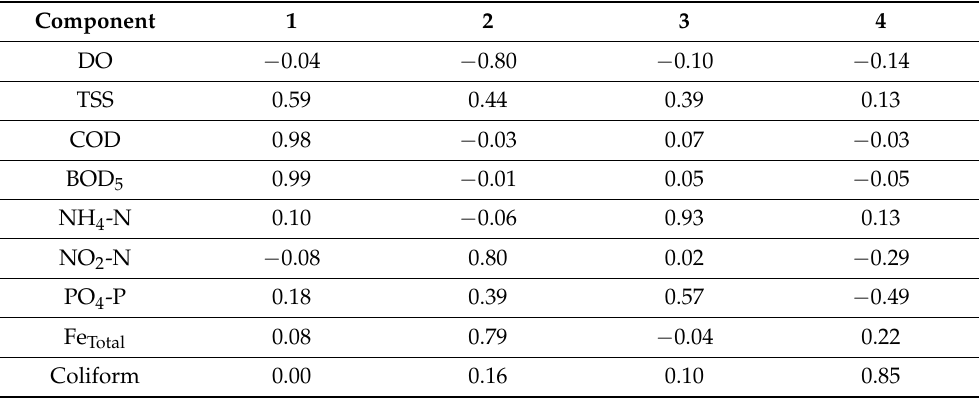
Table 4. Rotated component matrix with the resulting 4 components representing biodegradable organic loading (1), highly oxidizable components (2), nutrients (3), and microbial pollution